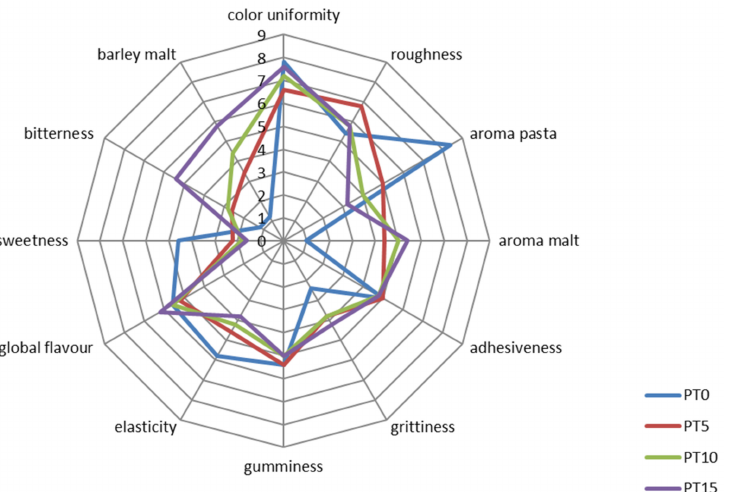
Figure 2. Sensory scores of quality attributes of pasta fortified with debittered trub powder (DTP) at different addition levels (PT0 blue line; PT5 red line; PT10 green line; PT15 purple line). PT0: pasta formulated with 100% durum wheat semolina. PT5, PT10, PT15: 95:5, 90:10, 85:15 durum wheat semolina:DTP,